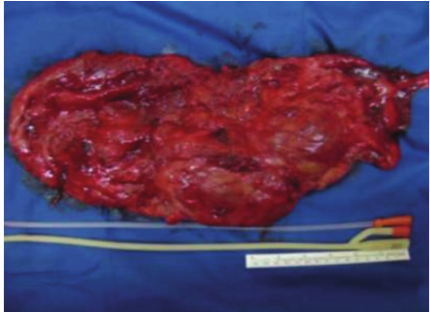
Figure 1: Preoperative view of the abdomen .